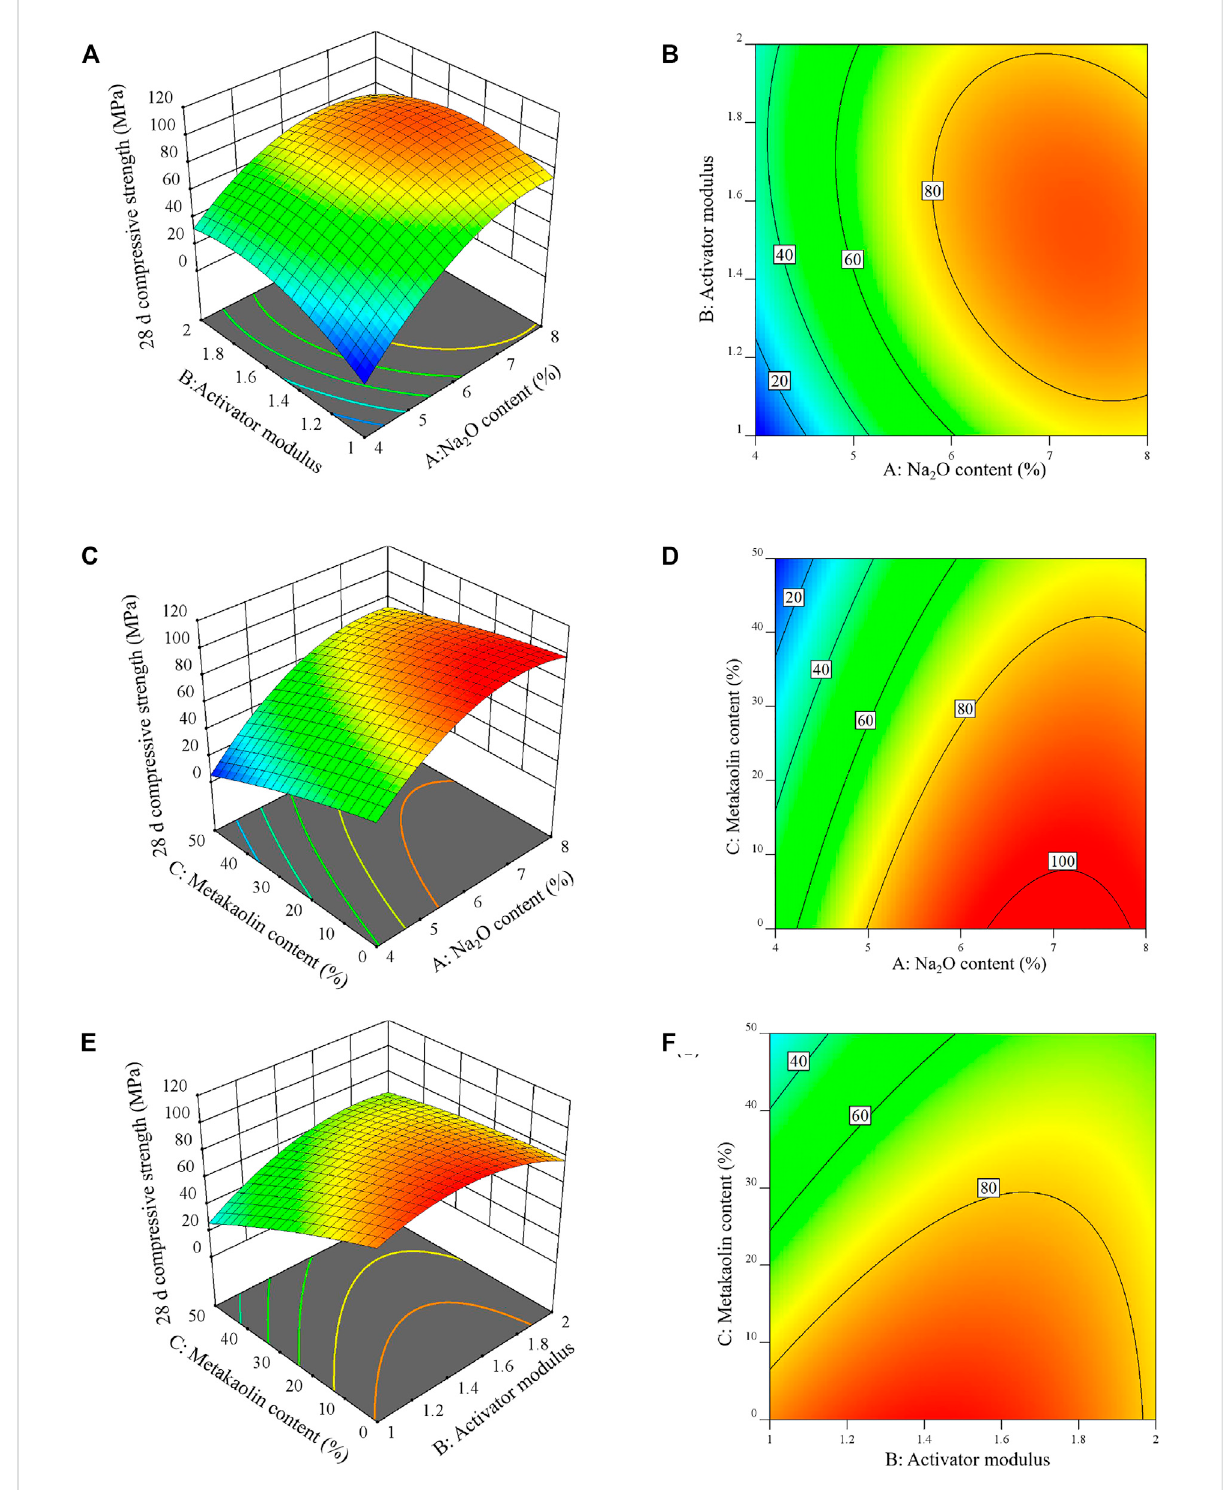
FIGURE 5 3D response surface diagrams of compressive strength of